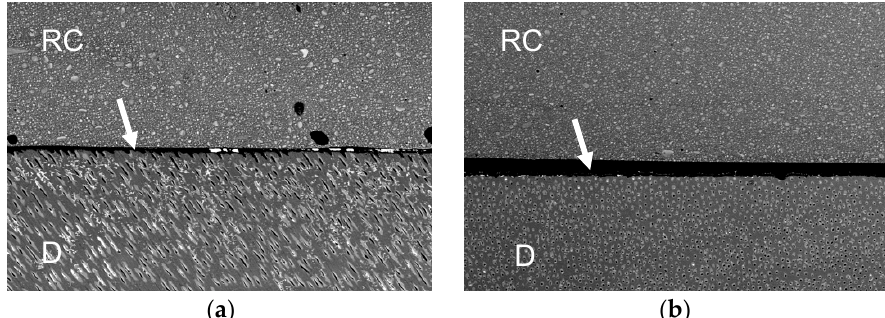
Figure 4. Backscatter SEM images of the resin–dentin adhesive interfaces of OCU after 24 h. ( a ) Received by the manufacturer; ( b ) expired. RC, resin composite. D, dentin. White arrows indicate adhesive layer; 250x.